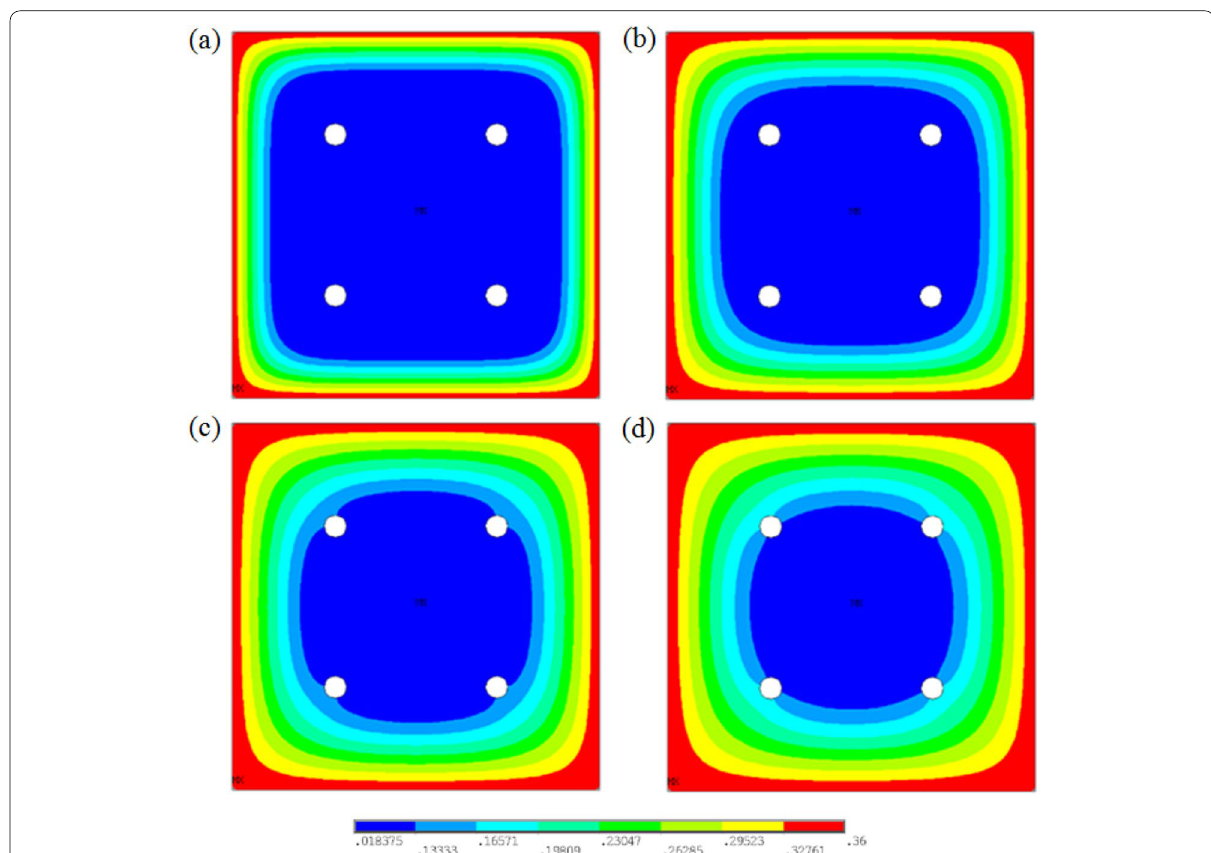
Fig. 11 Contours of carbon dioxide concentration in the 0.75% PVA fiber concrete component with 6 mm length: a for 7 days, b for 14 days, c for 21 days, and d for 28